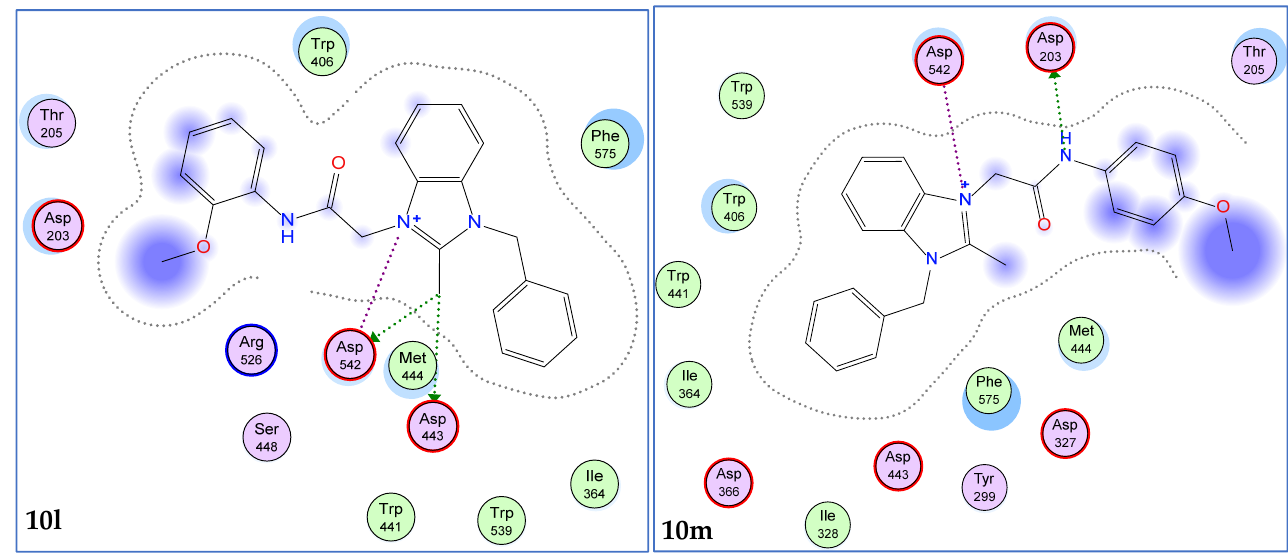
Figure 2. 2D interaction modes of active compounds ( 10a , 10d , 10g , 10h , 10l , and 10m ). The blue color indicates ligand exposure and the green color dotted lines indicates the interactions of receptor enzyme with ligands.